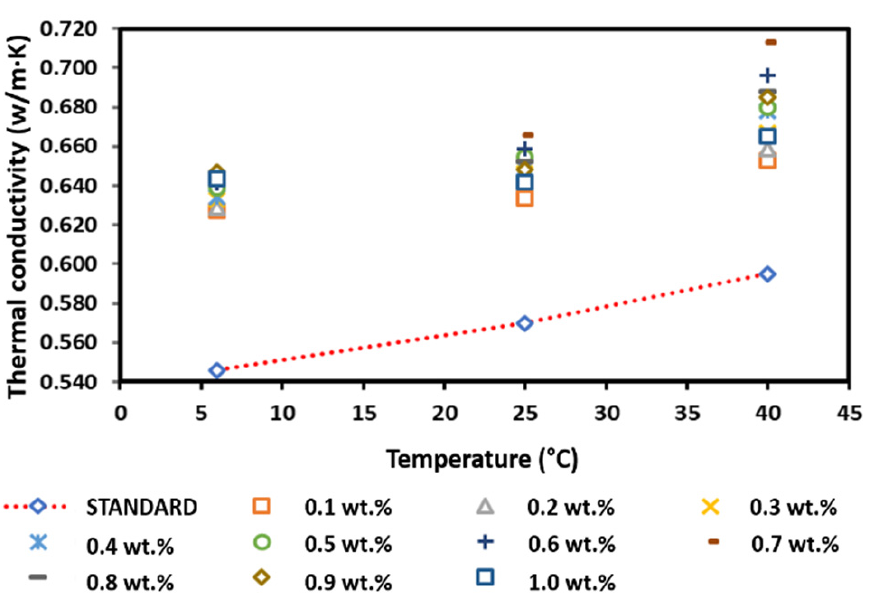
Figure 16. Comparison of the thermal conductivity between the surface ‐ oxidised CNF ‐ based nanofluids with PVP and the pure base fluid at various concentrations and temperatures.